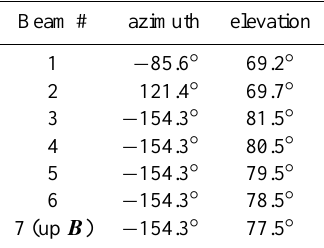
Table 1. PFISR beam